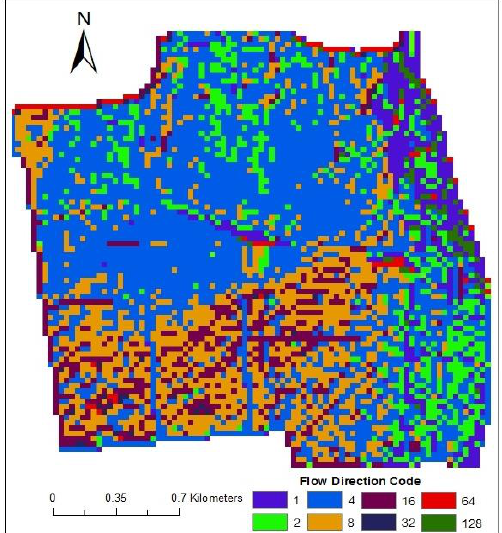
Figure 5. Input flow direction map